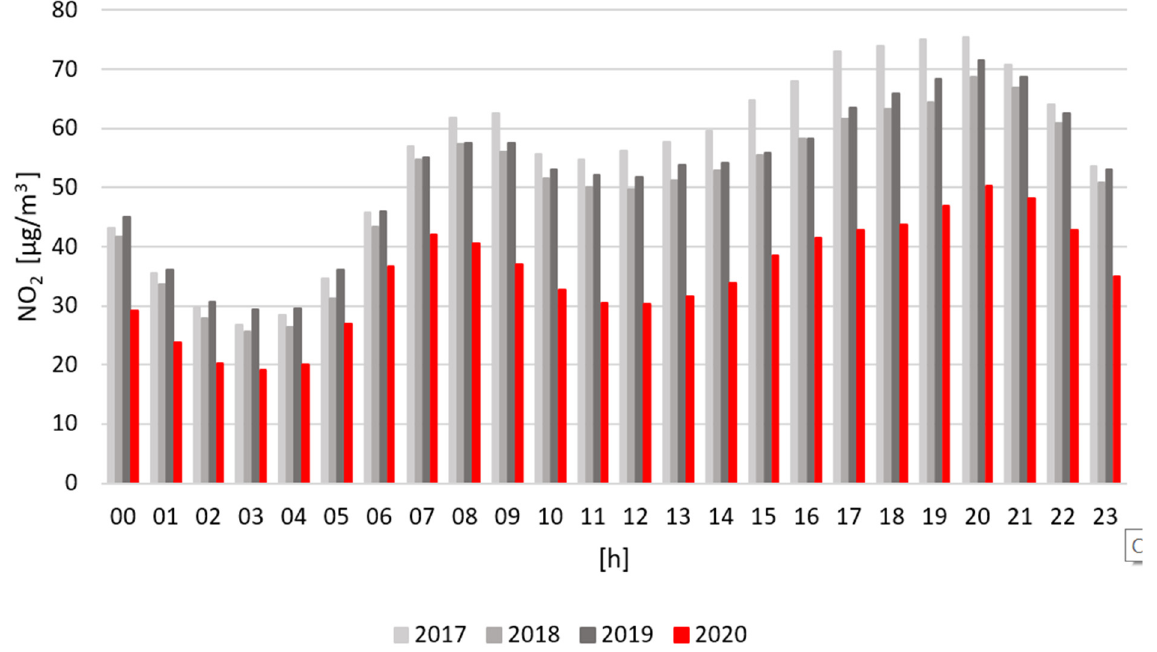
Figure 9. Summary of the mean NO 2 concentrations [ μ g/m 3 ] at the air quality monitoring station at al. Niepodleg ł o ś ci in Warsaw. Calculation for all days in the period 2017–2020.